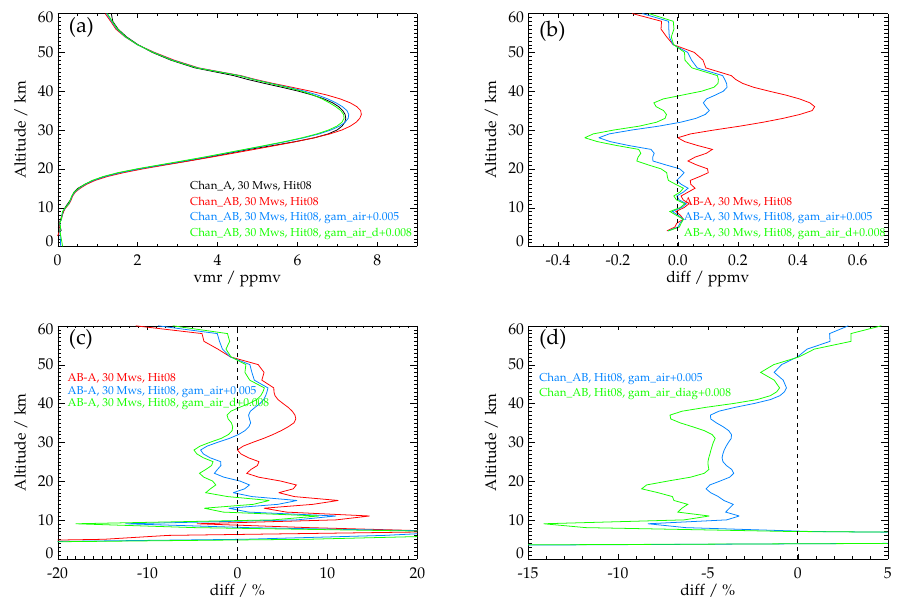
Figure 11. (a) Mean ozone profiles of 59 orbits from 3 January, 1 April, 2 July and 2–3 October 2009, retrieved in MIPAS channels A (black) and AB (red) using the HITRAN-2008 spectroscopy (see Fig. 1). The blue profile results from retrieval in MIPAS channel AB after an increase in the air-broadened half widths by a value of 0.005cm − 1 atm − 1 at 296K, and the green profile from retrieval after increase in the air-broadened half widths of the strong lines on the main diagonal in Fig. 8b by 0.008cm − 1 atm − 1 at 296K. (b) Absolute and (c) relative differences between retrievals in channels AB and A. (d) Differences between channel AB retrievals with increased air-broadened half widths and channel AB retrievals using the unmodified HITRAN-2008